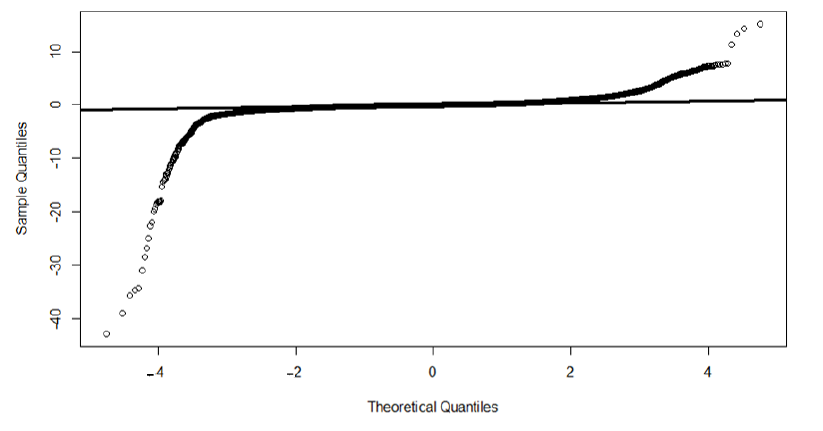
Figure 6. Normal QQ-plot of the discrepancies model (error model) of the Allo zone (DEM05-DEM02).